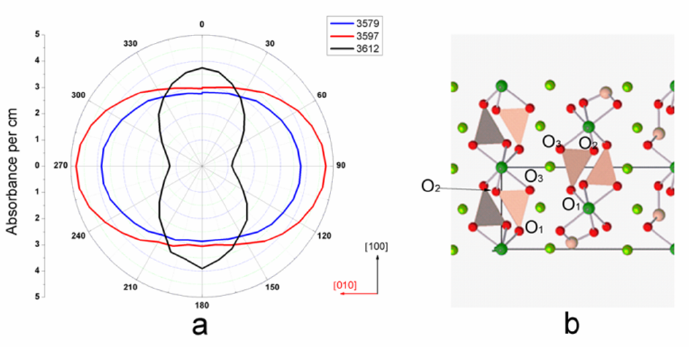
Figure 8. ( a ) The pleochroic scheme of the OH stretching band of the (001) plane of forsterite (absorbance intensity vs. sample to polarizer angle). ( b ) Top view of the atomic structure of the (001) plane of forsterite crystals.